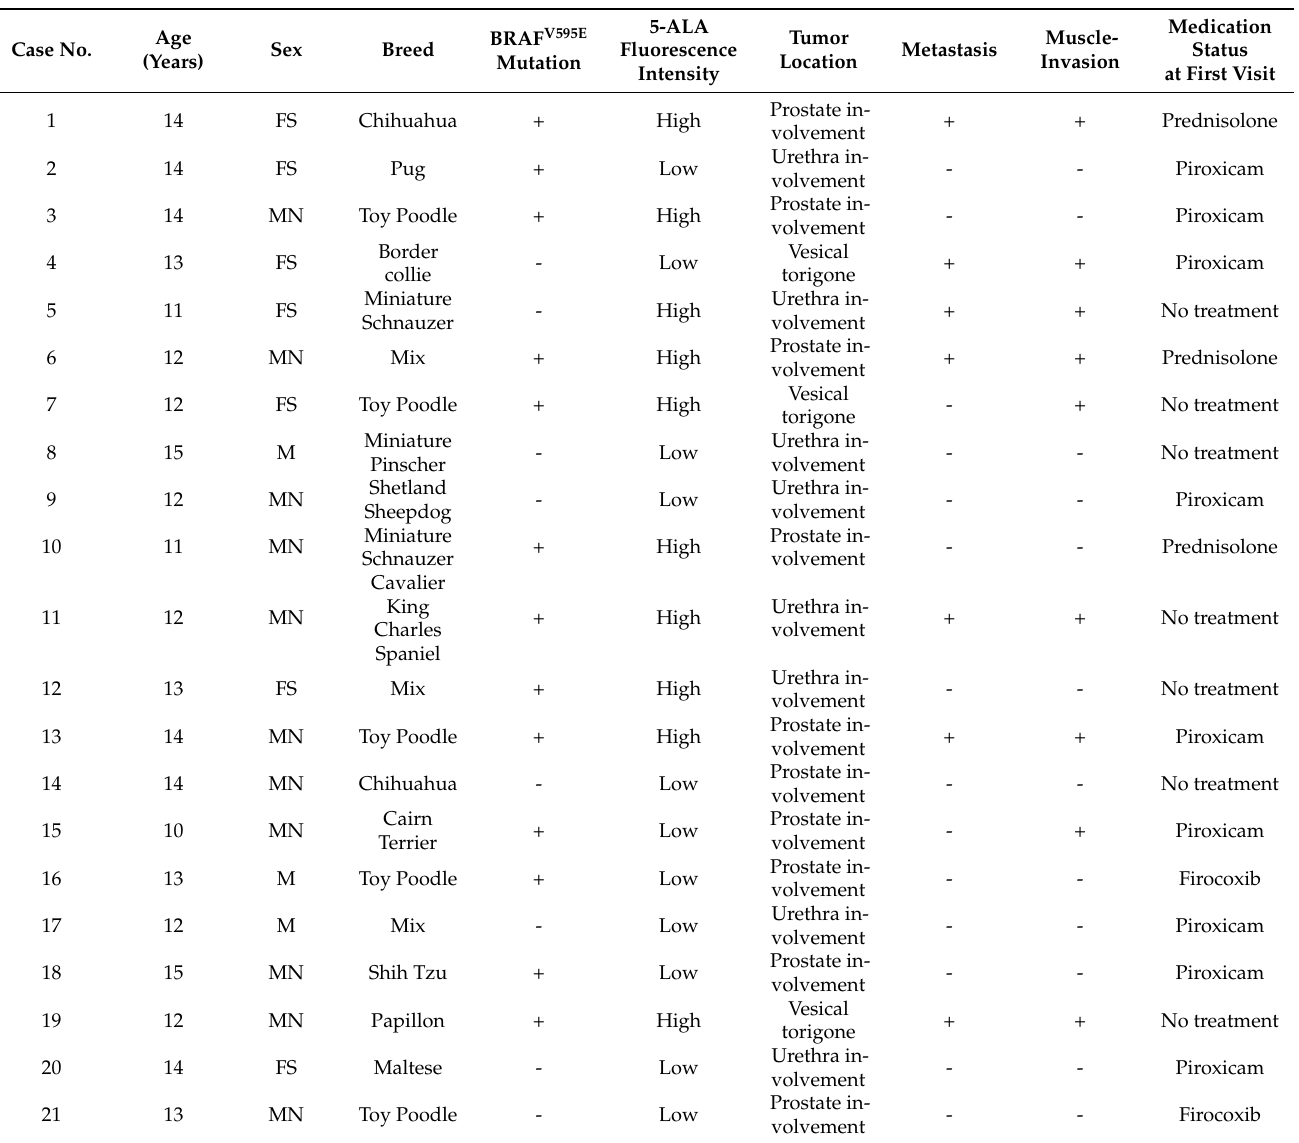
Table 1. Profiles of the dogs with urothelial carcinoma in this